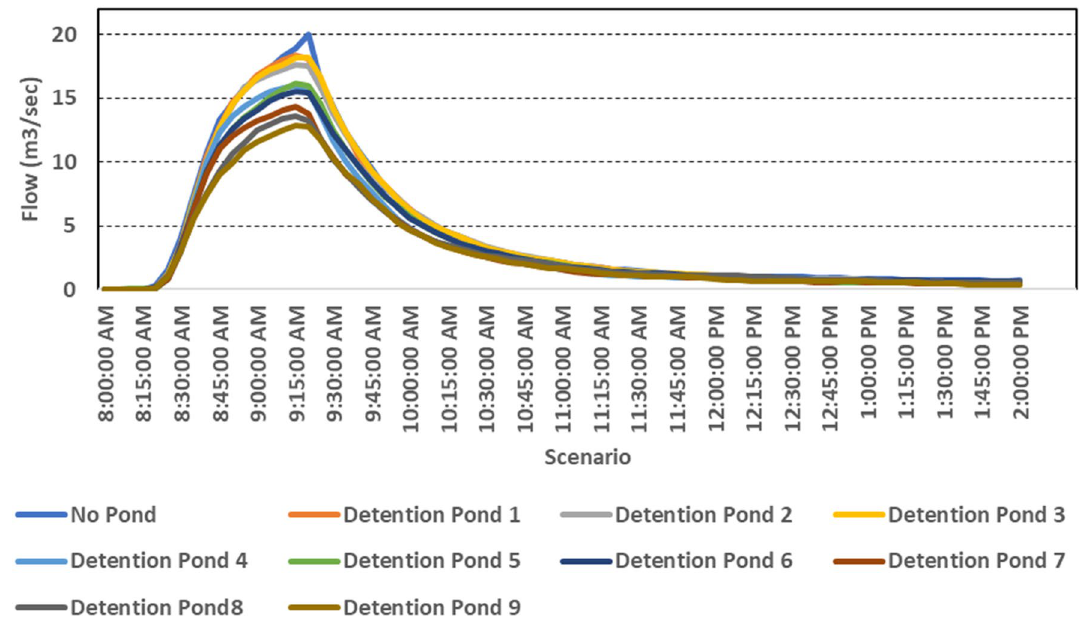
Figure 12. Hydrographs showing flow reduction when different detention ponds were considered compared to the base scenarios without detention pond.